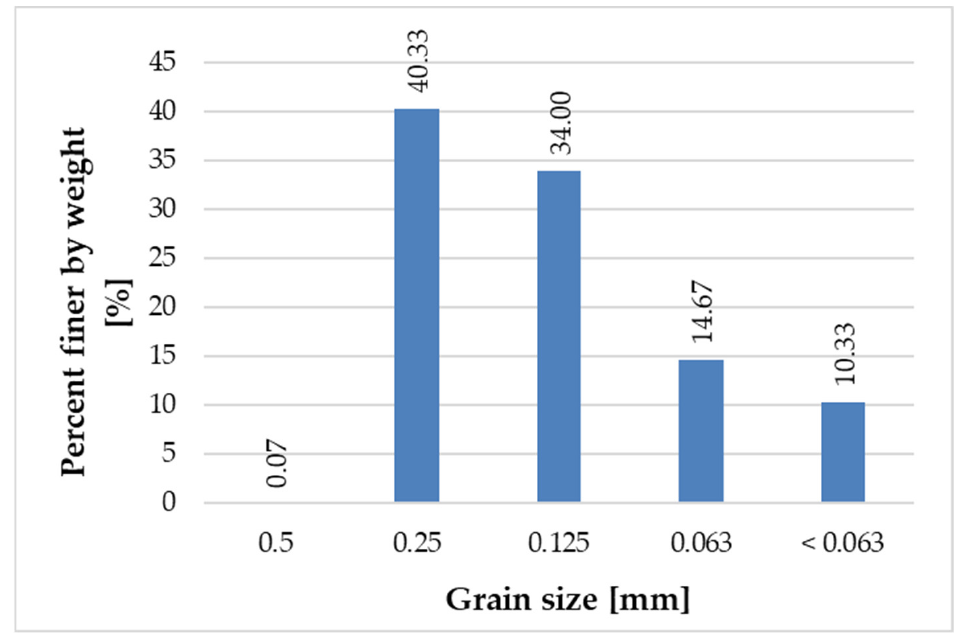
Figure 5. Grain size representation of recycled glass fraction 0.0/0.5 mm.